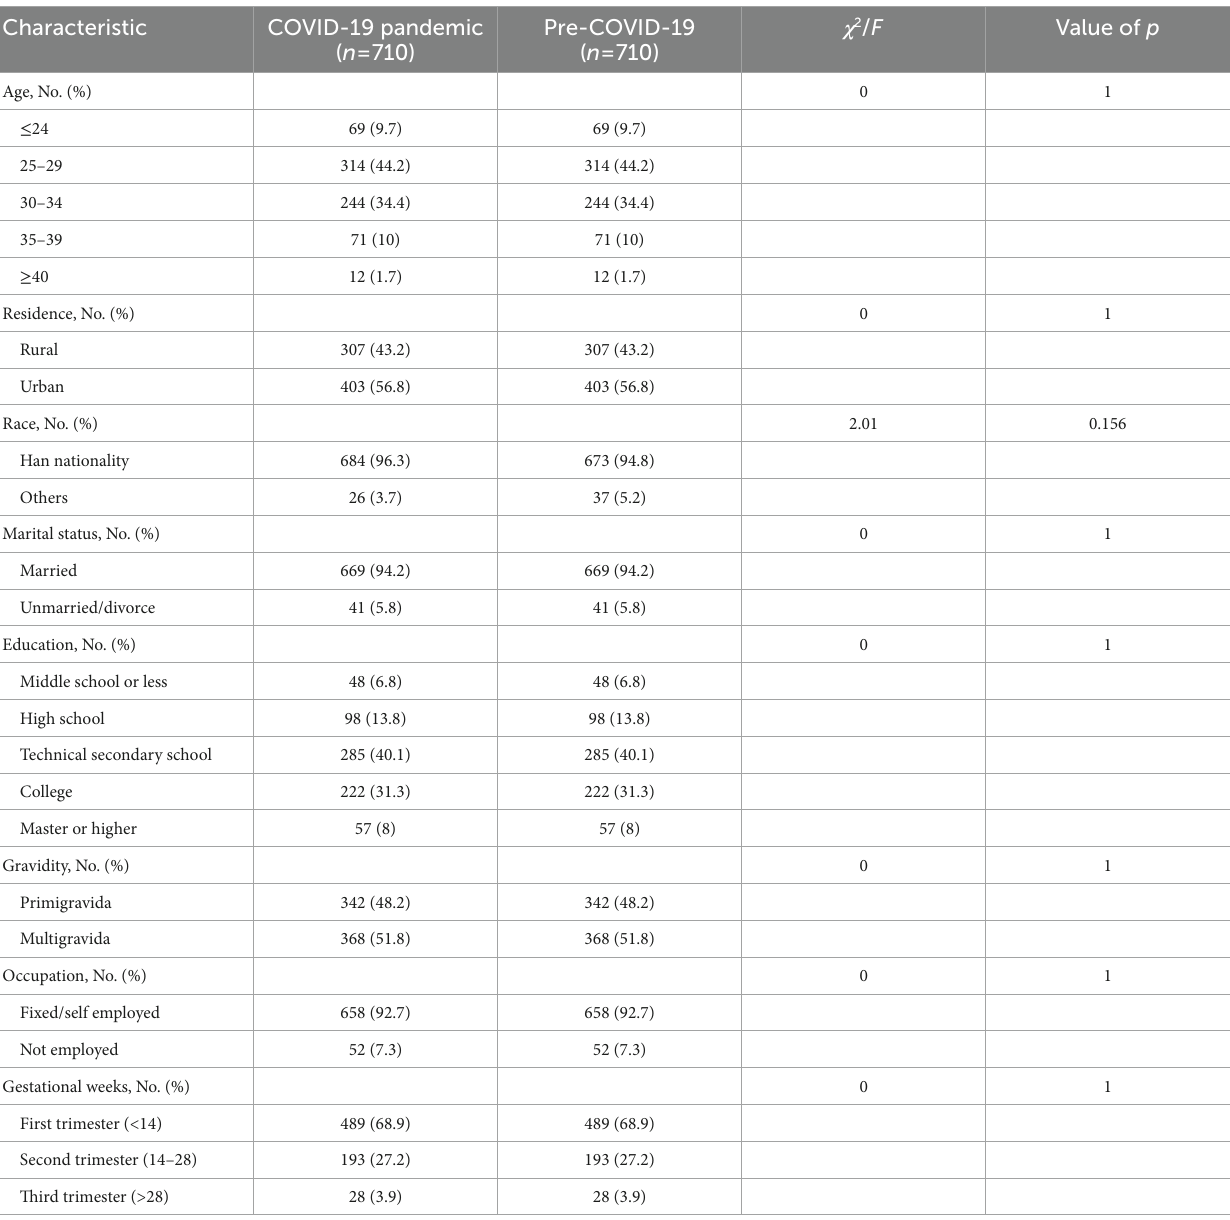
TABLE 3 Demographic characteristics between the two matched groups.